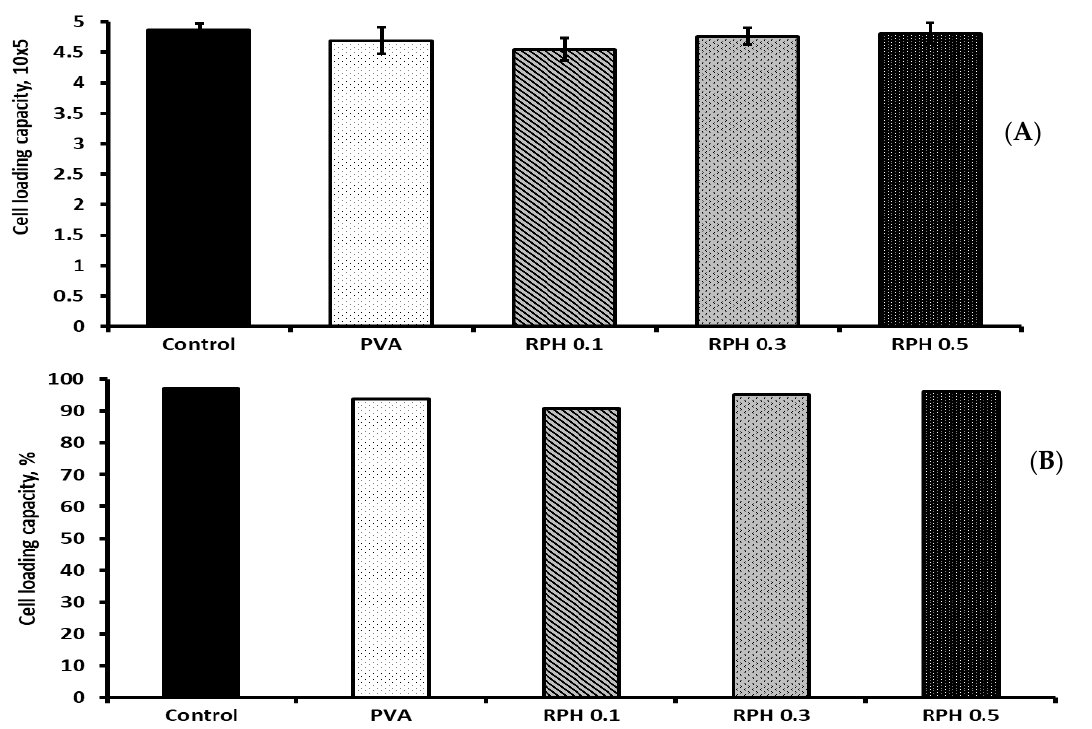
Figure 10. Cell-loading ability actual ( A ) and percentage ( B ) of RPHX hydrogels using bone marrow mesenchymal stem cells for 6 h. Control cells treated without hydrogel, PVA solution 15 wt.%, RPH 0.1-0.1% retinol PVA, RPH 0.3-0.3% retinol PVA, RPH 0.5-0.5% retinol PVA.